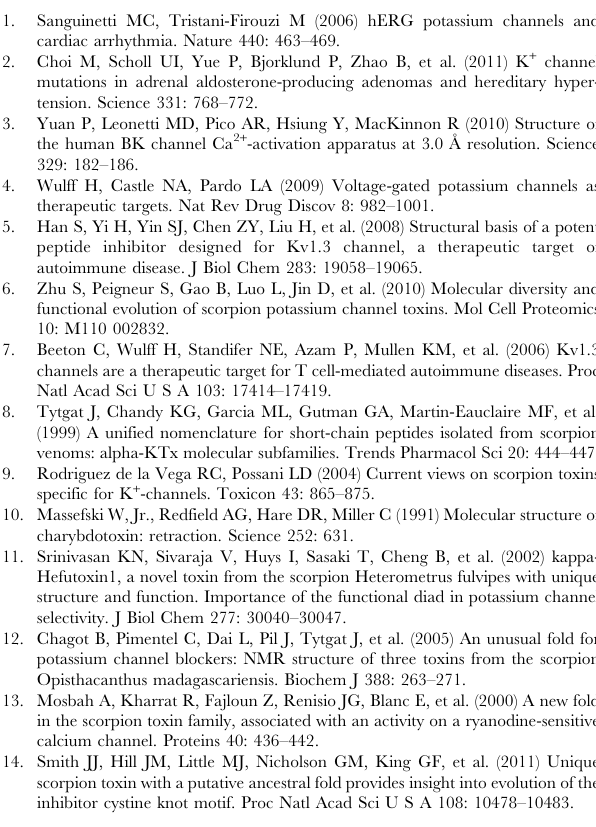
Figure S4 Summary of the NOE connectivities according to NOESY spectrum at 120 ms of mixing time and C a H chemical shift index (CSI). Bar thickness indicates the intensity of NOE connectivities, with thicker bars representing stronger NOEs. (TIF) Figure S5 Values of backbone amide heteronuclear 1 H– 15 N NOEs of ImKTx104. The NOE values are shown by red spot and line by residue number, and black bars indicate standard deviations. (TIF) Figure S6 Structure comparison of ImKTx104 with the classical CS a / b scorpion toxin BmP01. (A) Structure of BmP01 (PDB code:1WM7). The representative amino acid residues were marked. (B) and (C), Structure of ImKTx104 (PDB code:2LIX). The representative amino acid residues were also marked. (TIF) Table S1 Structure statistics for ImKTx104 at pH 5 (20 structures).